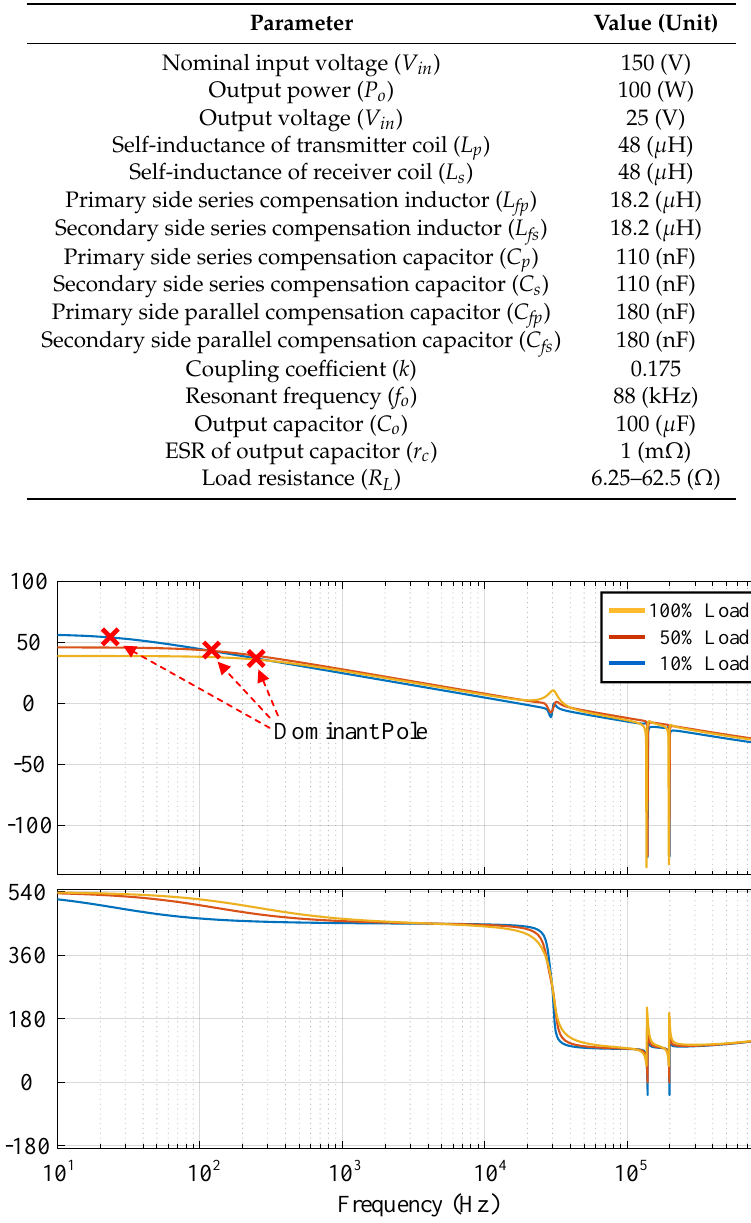
Figure 8. Block diagram of output voltage control. Table 1. System specifications and circuit parameters.